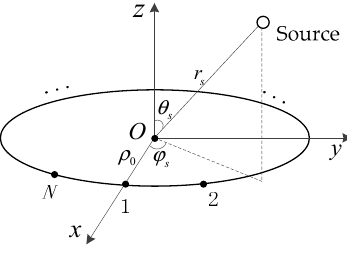
Figure 1. Geometry of a uniform circular array (UCA) with a single source.